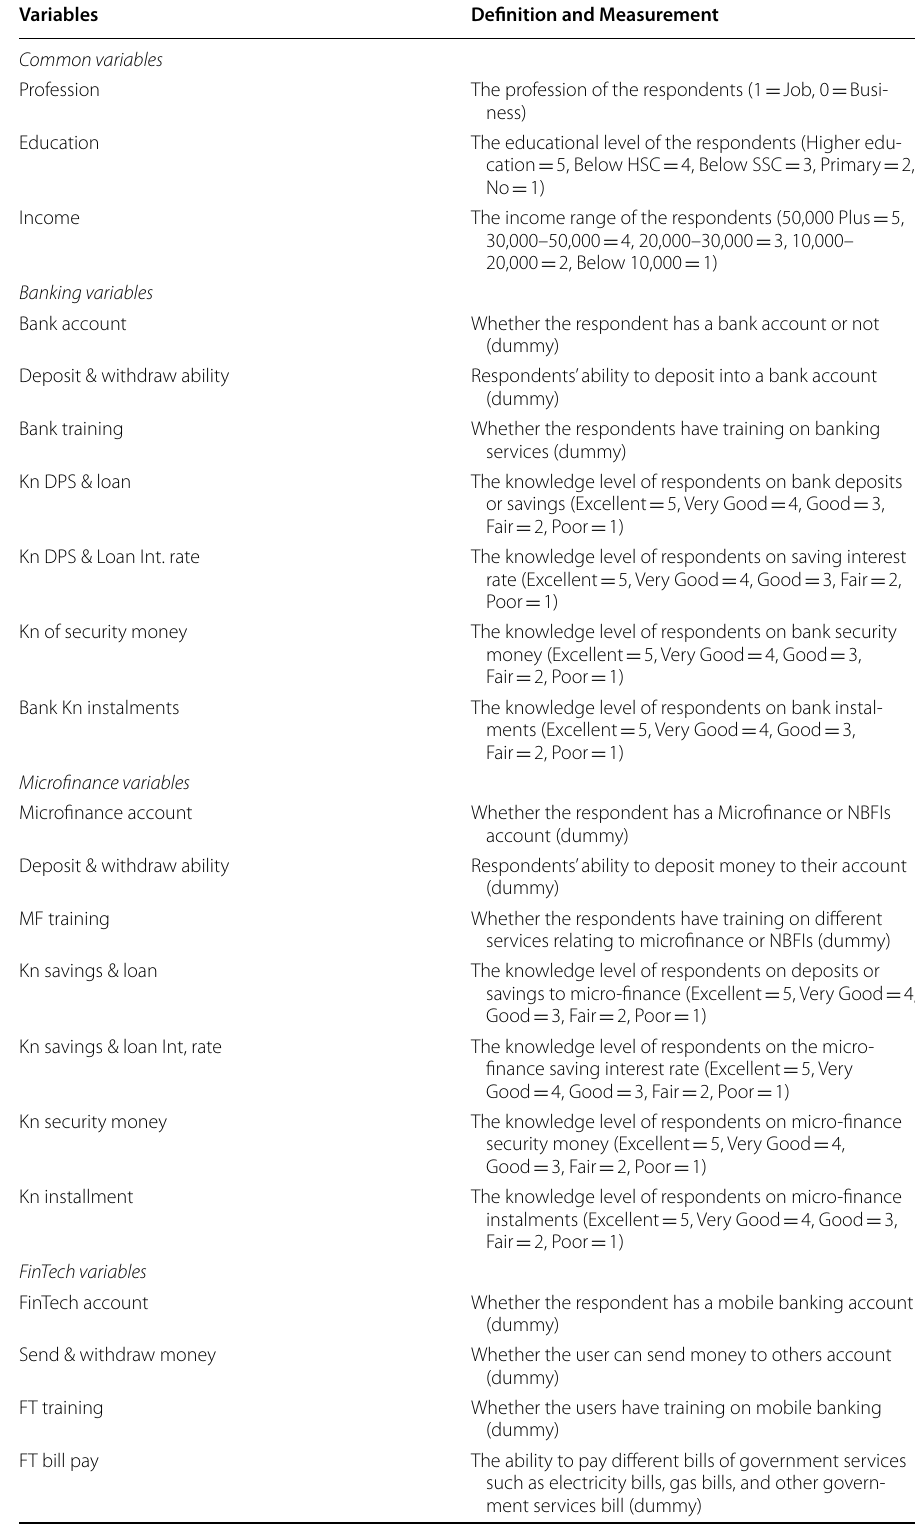
Table 2 Measurement of variables. Source : Authors’ experiment